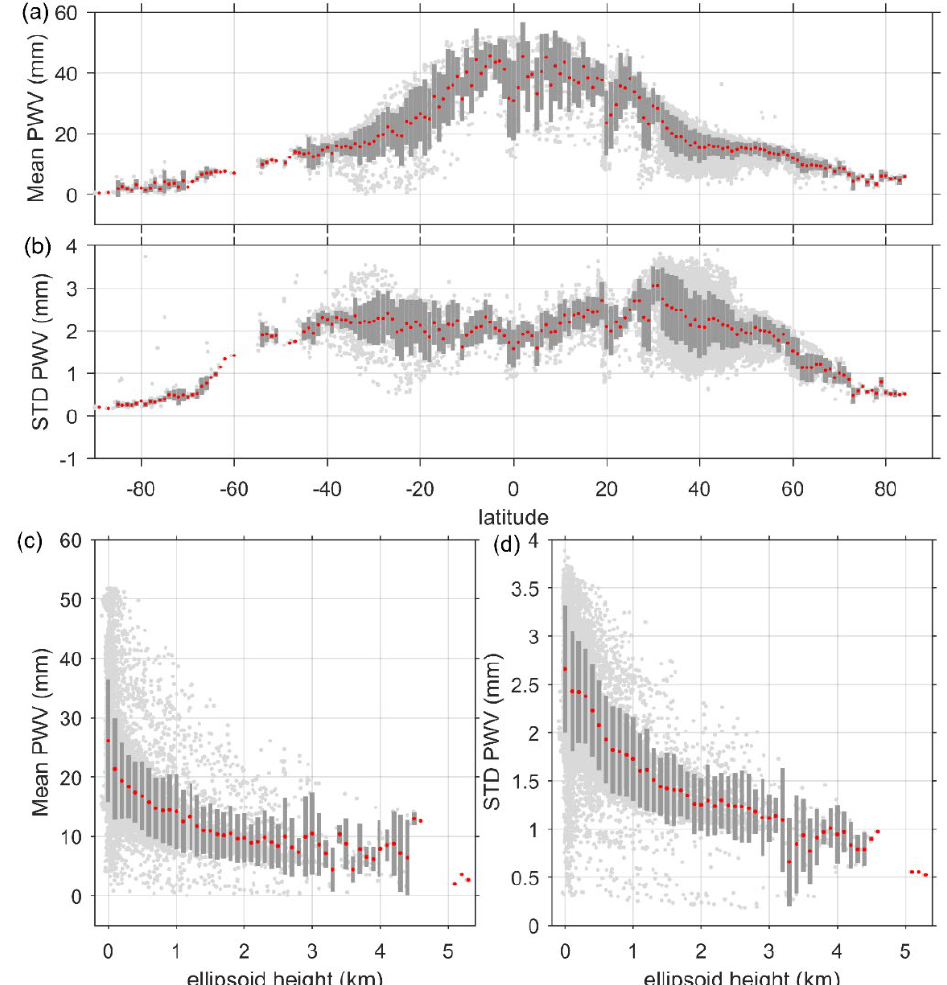
Figure 6. Distribution of mean PWV and PWV standard deviation (STD) with latitude and ellipsoid height. ( a ) PWV mean with latitude, ( b ) PWV STD with latitude, ( c ) PWV mean with ellipsoid height, ( d ) PWV STD with ellipsoid height. Light gray dots indicate each station, red dots indicate group means, and dark gray bars represent group STD. Note: the groups for latitude and ellipsoid height are in intervals of 1° and 100 m, respectively.